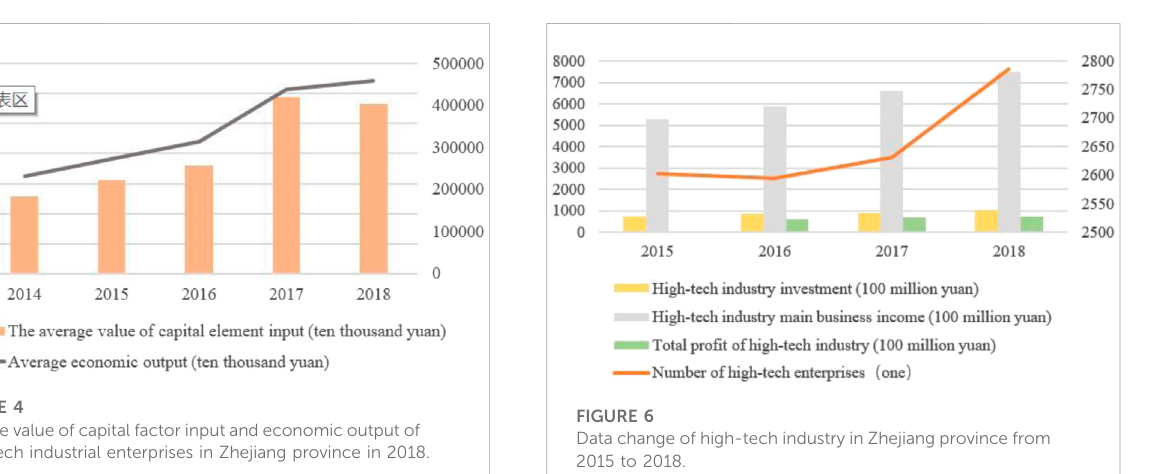
FIGURE 4 Average value of capital factor input and economic output of high-tech industrial enterprises in Zhejiang province in 2018.